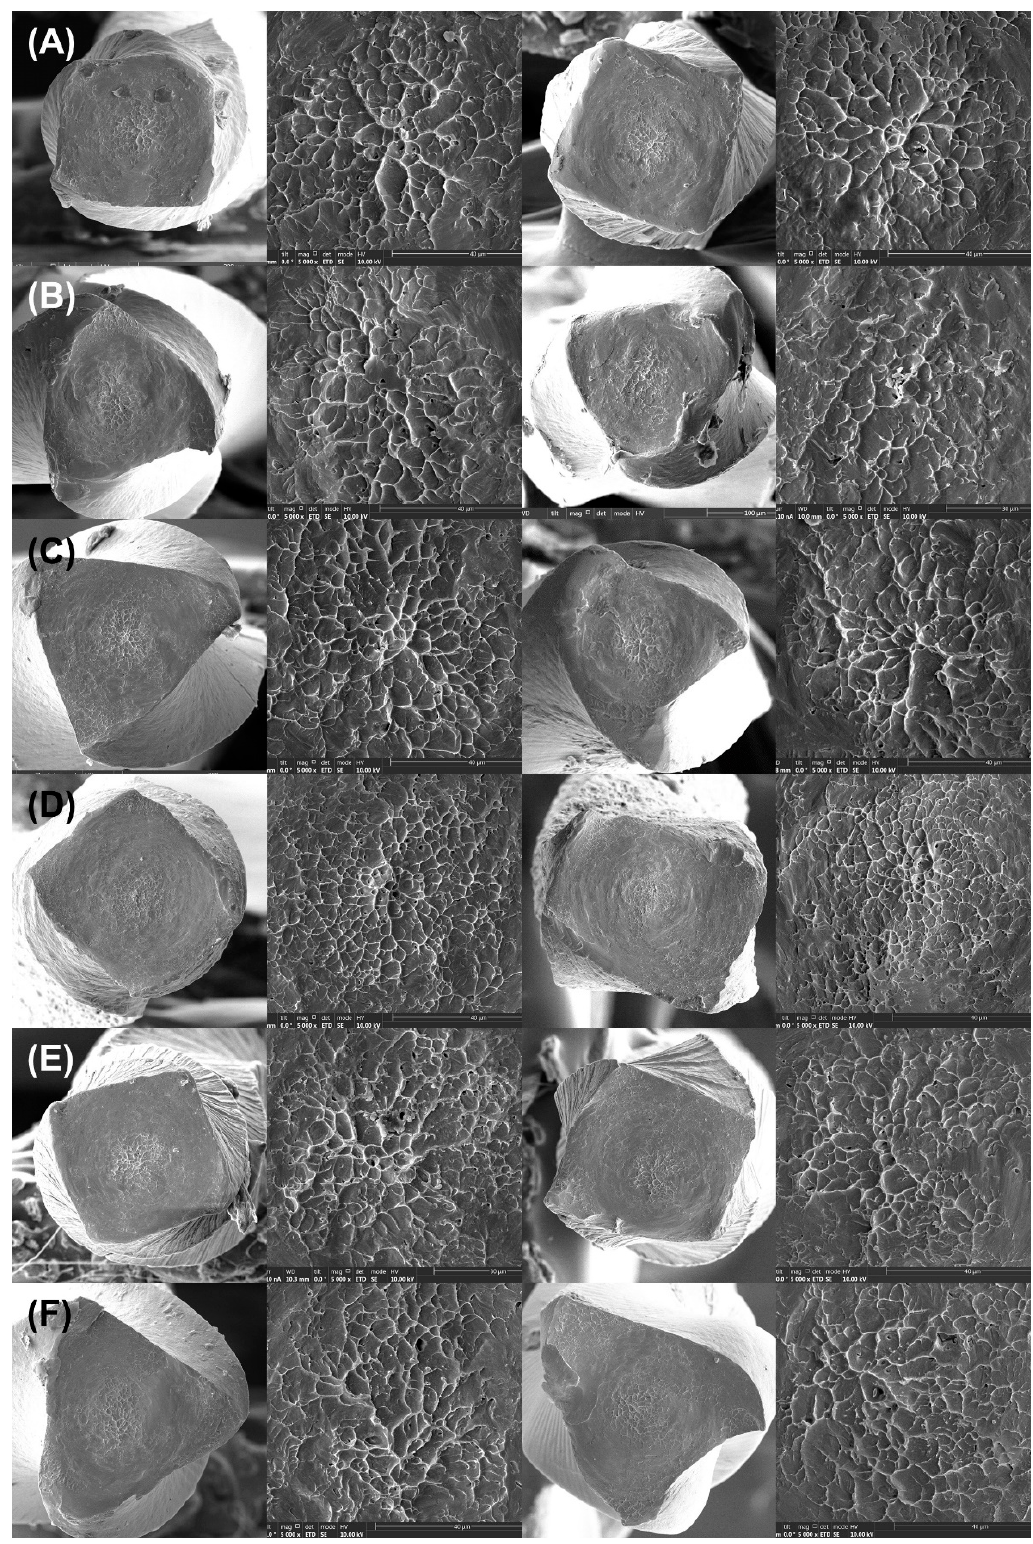
Figure 6. SEM images of the fractured surfaces of instruments. The left two images in each row show fractured surface of instrument in straight mode and its magnified view of the central area; the right two images are fractured surface of instrument in flexural mode and its magnified view. ( A ) PathFile; ( B ) RaCe; ( C ) RaCe Evo; ( D ) HyFlex EDM; ( E ) TruNatomy Glider; ( F ) V Taper 2H (original magnification × 1000, × 5000).